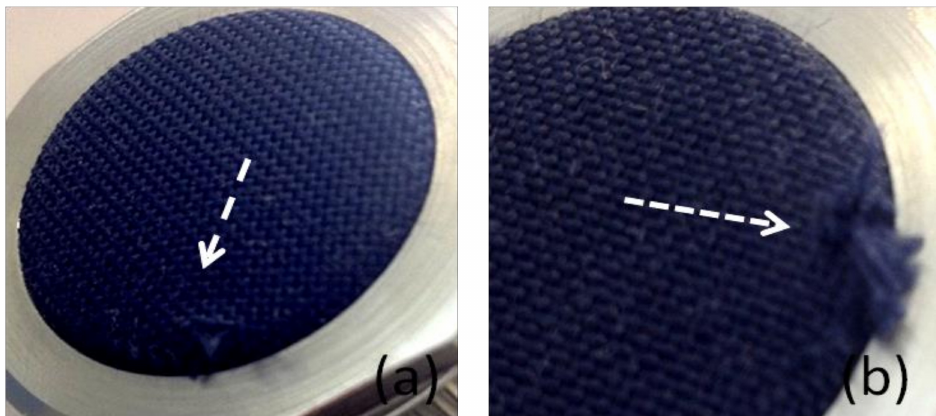
Figure 8. Sample deterioration during the Martindale test for the untreated PP, represented by pilling ( a ) and yarns breakage ( b ).